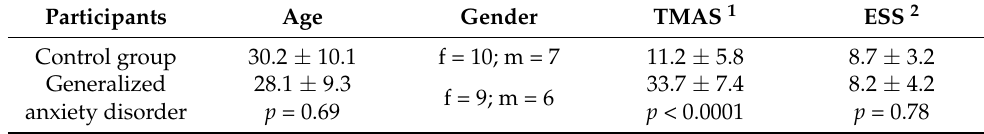
Table 2. Age, gender, and psychometric scores in studied cohorts; the data are mean ± standard deviation.